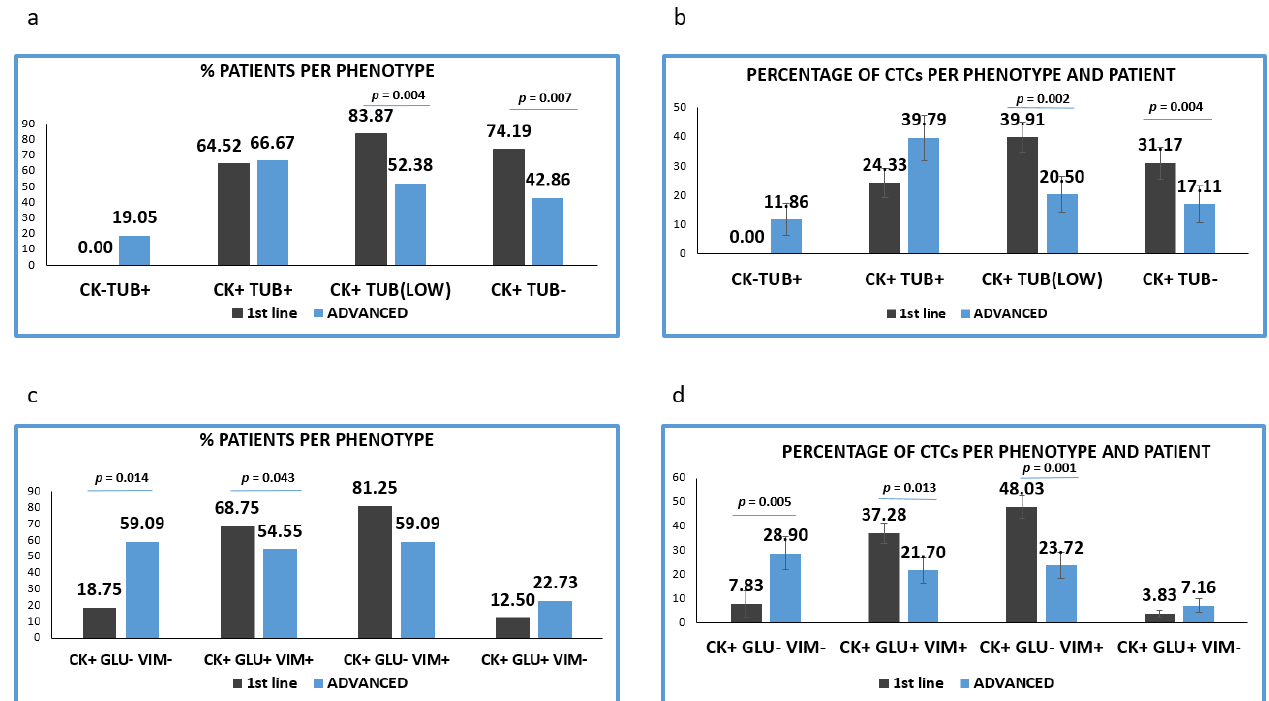
Figure 3. Expression of Cytokeratin (CK), Detyrosinated α -tubulin (GLU) and Vimentin (VIM) in treatment naïve versus pre- treated patients’ samples. ( a ) Percentage of patients belonging to discrete CTCs’ phenotype, regarding the CK/TUB/CD45 staining in treatment naïve (1st line) versus pre-treated (advanced) patients. Each patient was considered as positive for a distinct phenotype, if he/she’s harboring at least one CTC with this phenotype; ( b ) Percentage of CTCs per patient and per phenotype in treatment naïve (1st line) versus pre-treated (advanced) patients, regarding the CK/TUB/CD45 staining; ( c ) Percentage of patients belonging to discrete CTCs’ phen otype, regarding the CK/GLU/VIM staining, in treatment naïve (1st line) versus pre-treated (advanced) patients. Each patient was considered as positive for a distinct phenotype if he/she’s harboring at least one CTC with this phenotype ; ( d ) Percentage of CTCs per patient and per phenotype in treatment naïve (1st line) versus pre-treated (advanced) patients, regarding the CK/GLU/VIM staining.